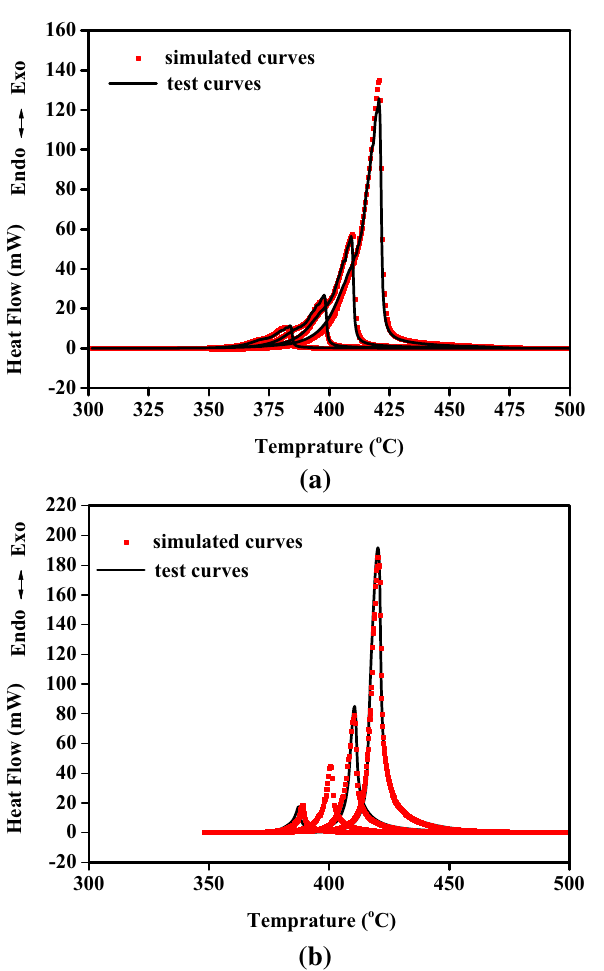
Figure 8. DSC measurements of y-PTACOT ( a ) and z-TACOT ( b ) at the heating rates of 2, 5, 10 and 20 °C/